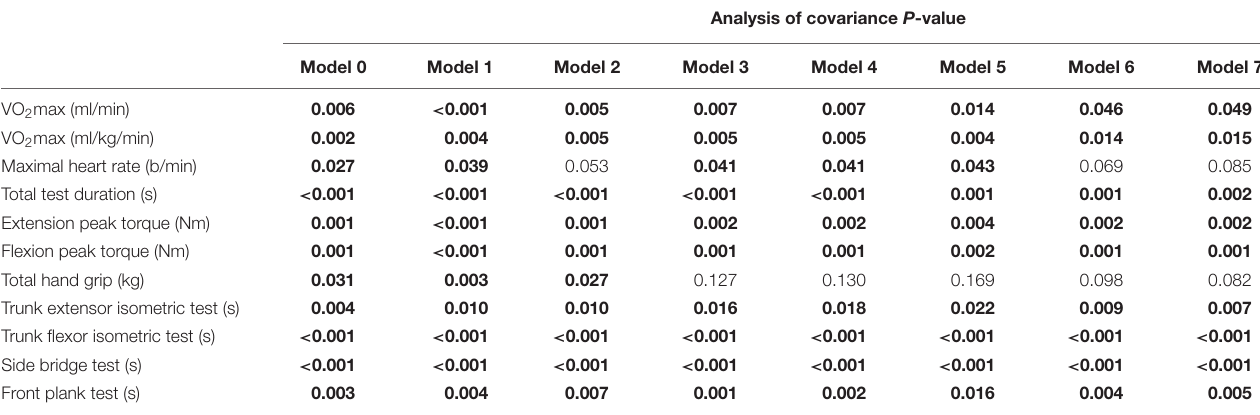
TABLE 2 | Changes in physical fitness outcomes adjusted by baseline values (Model 0), by baseline values and sex (Model 1), by baseline values and age (Model 2), by baseline values and changes in lean mass index (Model 3), by baseline values and changes in fat mass index (Model 4), by baseline values and changes in energy intake (Model 5), by baseline values and changes in sedentary time (Model 6), and baseline values and by changes in overall physical activity levels (Model